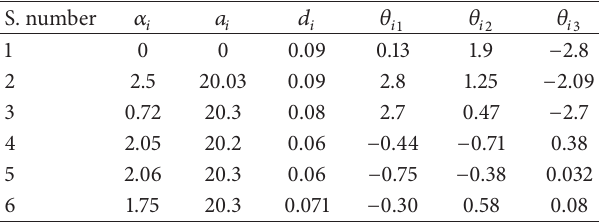
Table 3: Six-link manipulator design for server room